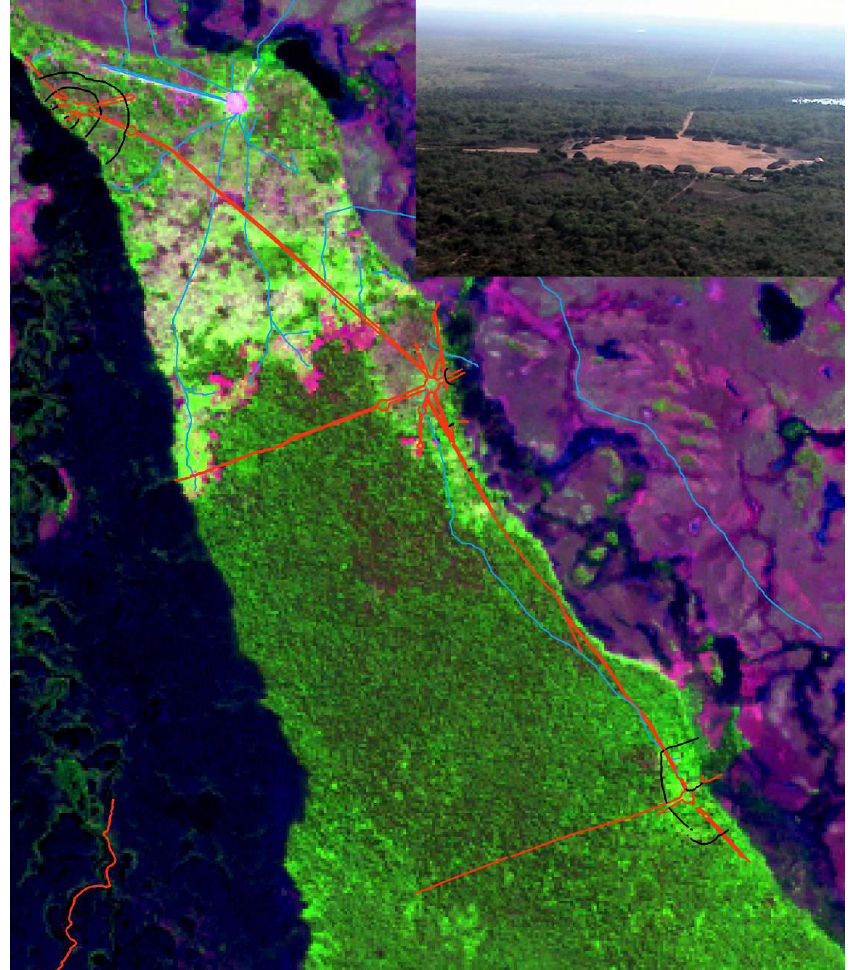
Figure 2. Core area of the northern cluster showing ritual political hub site (X13) and two major residential centers, located to the north (X6) and south (X18) of X13 (roads are denoted by red lines and peripheral ditches by black lines). Note: the Ipatse stream course appears as a meandering blue-black line along the eastern edge of the forested upland area (green), which is bounded to the west by the marshy lowlands of the braided Angahuku River (solid dark blue/black). Inset: Kuikuro village in 2003, which corresponds to pink dot with blue radial paths to the left of